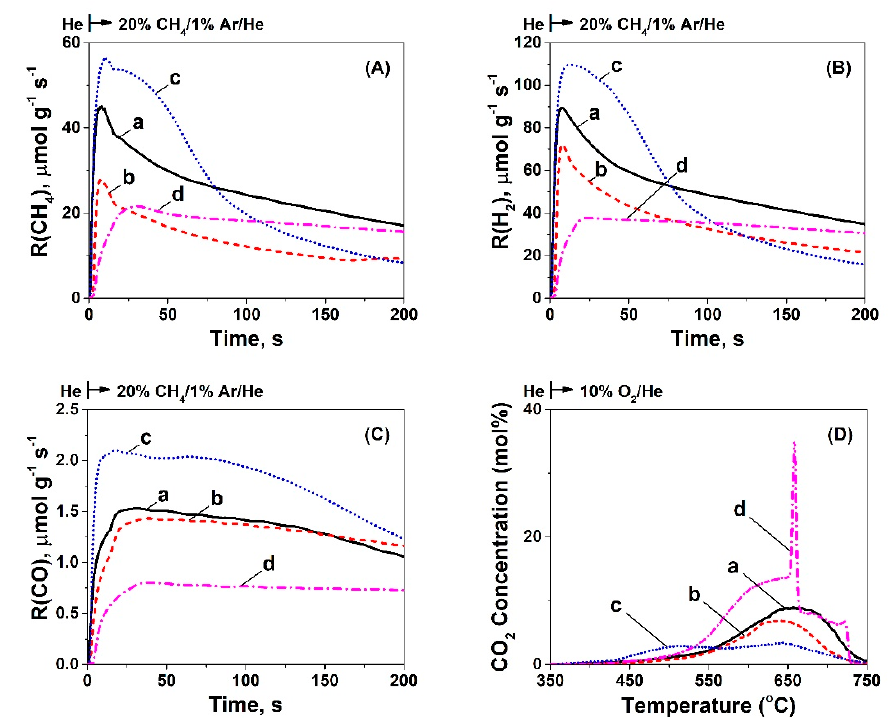
Figure 5. Transient rates ( µ mol g − 1 s − 1 ) of CH 4 consumption ( A ), H 2 ( B ), and CO ( C ) formation, as a function of time after the gas switch He → 20 vol% CH 4 / 1% Ar / He (50 NmL min − 1 ; GHSV ~30,000 h − 1 ) at 750 ◦ C. ( D ) Transient response curves of CO 2 concentration obtained during TPO of carbon formed after 30 min of methane decomposition (20% CH 4 / 1% Ar / He) at 750 ◦ C over 5 wt% Ni / CeO 2 prepared by (a) Thermal decomposition (TD), (b) Precipitation (PT), (c) Hydrothermal (HT), and (d) Sol-Gel (SG) method.